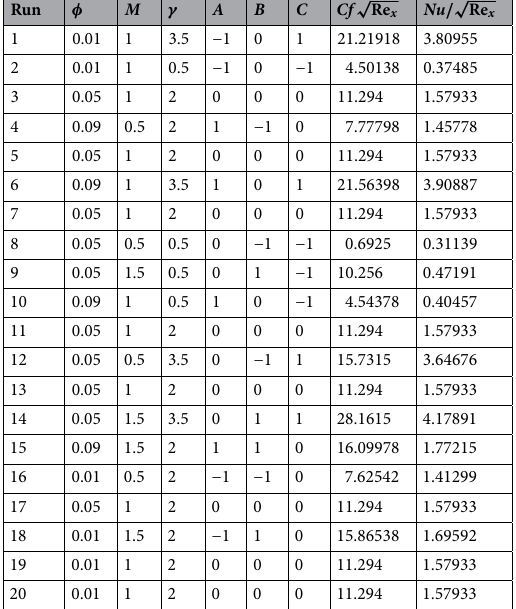
Table 4. Response results for Cf √ Re x and Nu / √ Re x regarding RSM design.